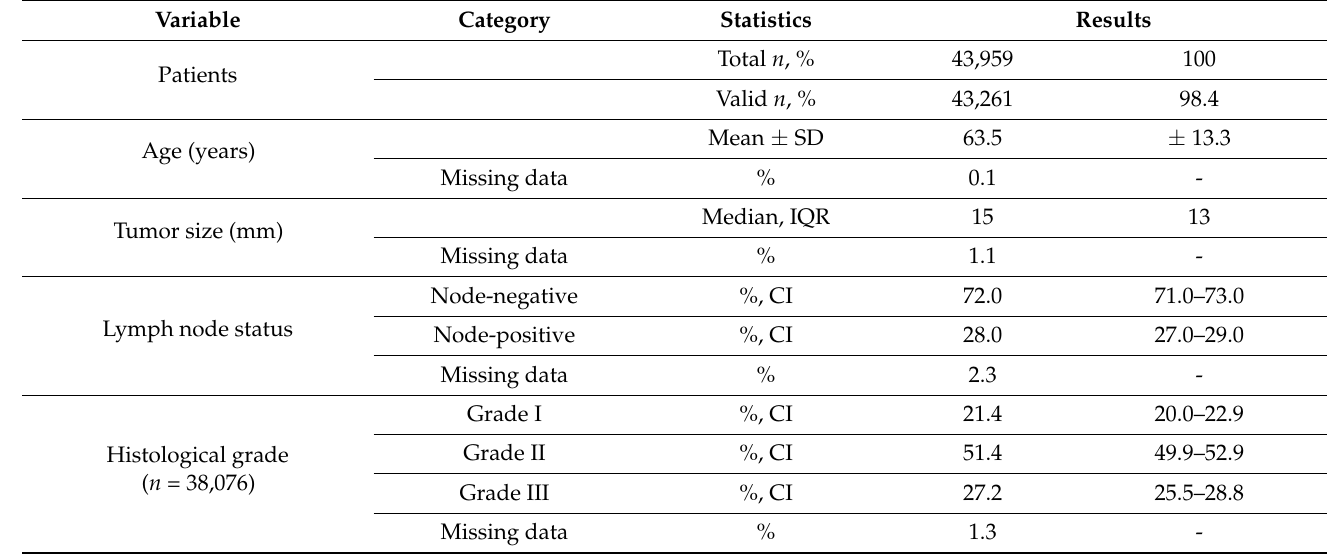
Table 1. Patient and tumor characteristics and treatment in 43,261 cases with biomarker assessment performed at 29 pathology